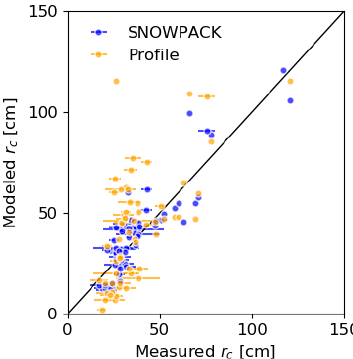
Figure 10. Modeled values of critical crack length (Eq. 8) with layer properties from SNOWPACK (blue dots) and from manually observed profiles (orange dots) vs. averaged critical crack lengths from PST experiments. Error bars indicate the range of measured critical crack lengths for each point. The black line is the 1 : 1